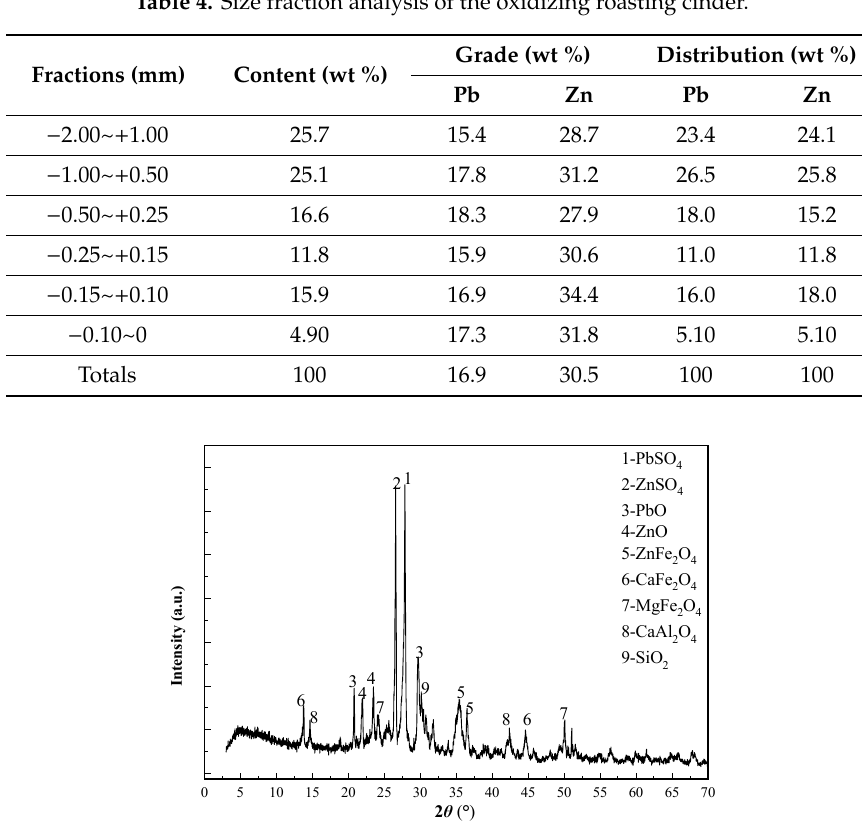
Figure 2. XRD diffractogram and identified phases of the oxidizing roasting cinder. Figure 2. XRD di ff ractogram and identified phases of the oxidizing roasting